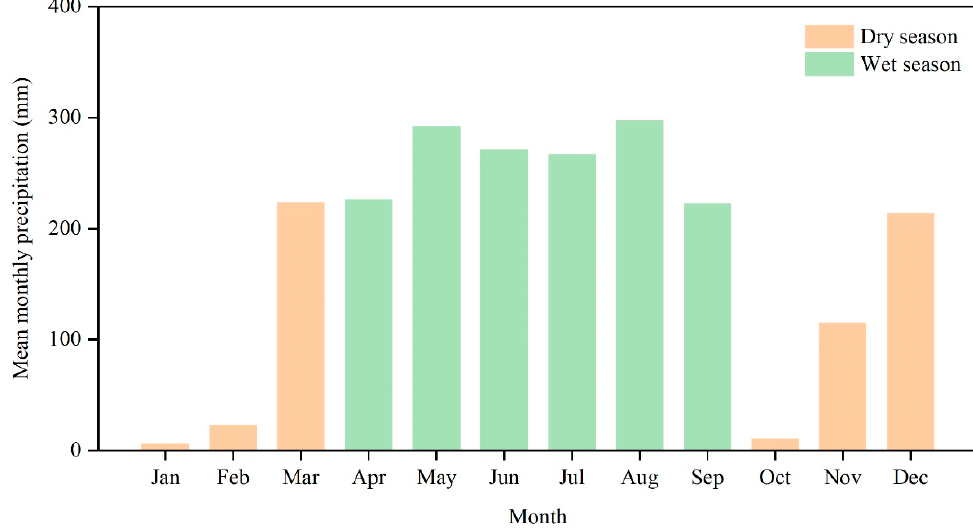
Figure 1. Mean monthly precipitation in the study area from 2013 to 2014.